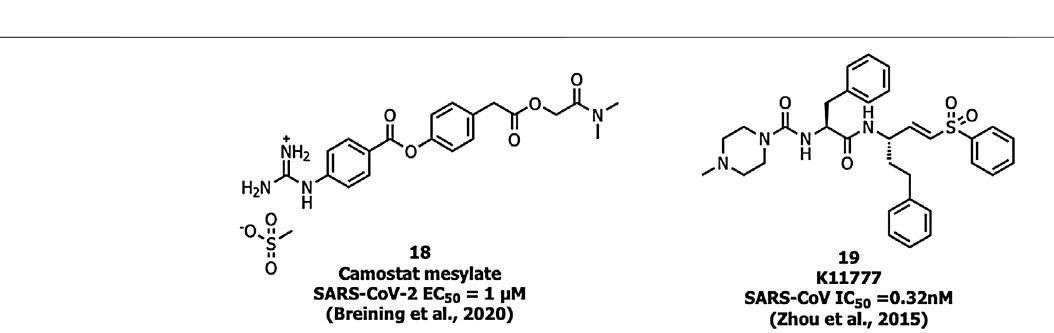
FIGURE 8 | Inhibitors targeting TMPRSS2.